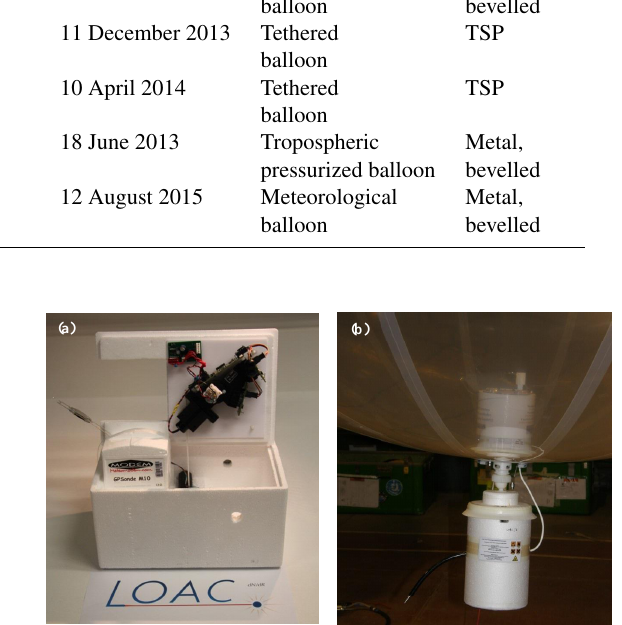
Figure 1. ( a , left) The LOAC gondola with a Meteomdem Company sonde for flight under meteorological balloons; ( b , right) the LOAC gondola below a low troposphere drifting